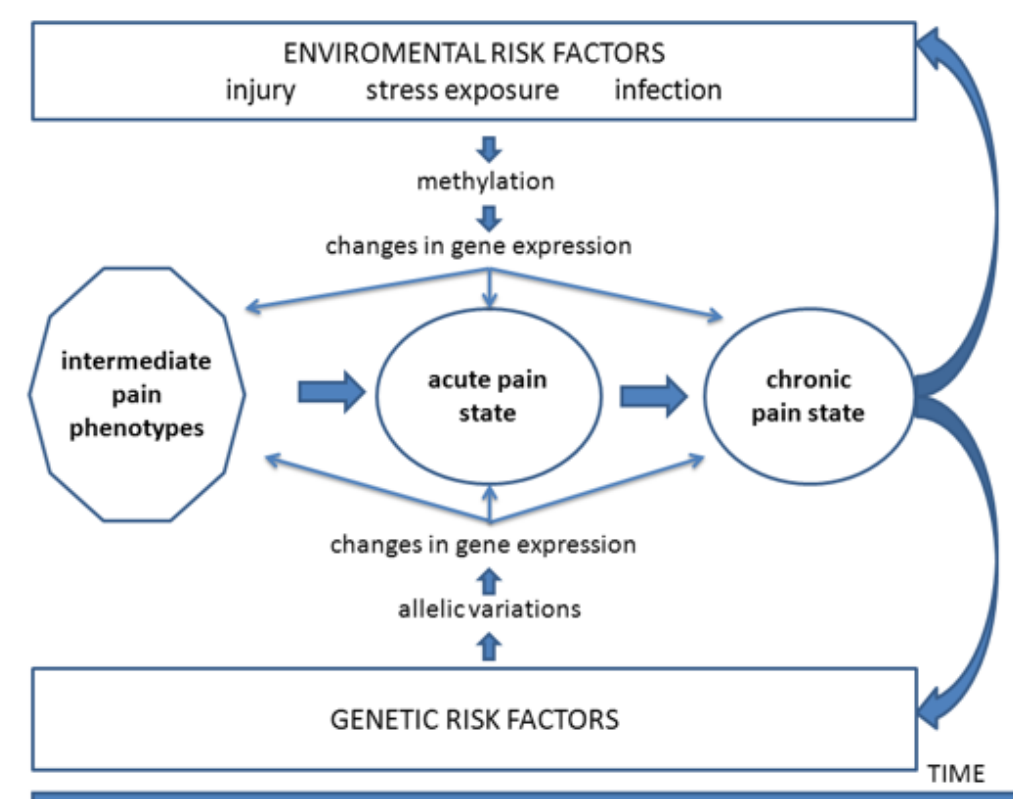
Figure 1. Mechanistic outline of processes by which genetic and environmental risk factors may influence orofacial pain. These include influences on intermediate pain phenotypes and the transition from an acute pain state to a chronic pain state that may further exacerbate these risk factors. From Meloto et al. [15].